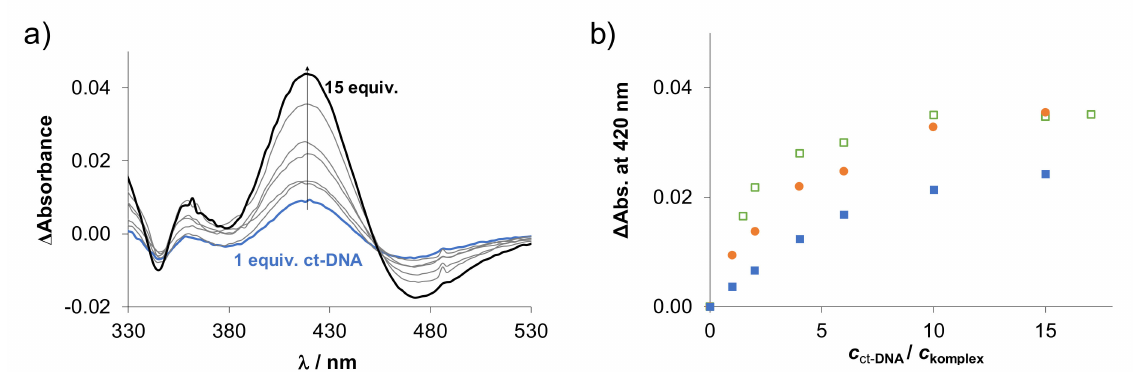
Figure 11. ( a ) UV-vis difference spectra of RhCp*–HQCl-D-hPro complex in the presence of various equiv. ct-DNA (difference spectrum = spectrum of the complex with ct-DNA–spectra of the complex and the ct-DNA alone). (Arrow shows the changes of the ∆ Absorbance values.) ( b ) Changes of ∆ Absorbance values ( ∆ Abs.) at 420 nm at increasing ct-DNA/complex ratio. Symbols for the ligands in the RhCp* complexes: HQCl-D-Pro ( (cid:3) ), HQCl-L-Pro ( (cid:4) ) and HQCl-D-hPro ( • ). { c complex = 88–100 µ M, c ct-DNA = 0–1.75 mM, c KCl = 4 mM; pH = 7.40 (20 mM phosphate buffer); (cid:96) = 1